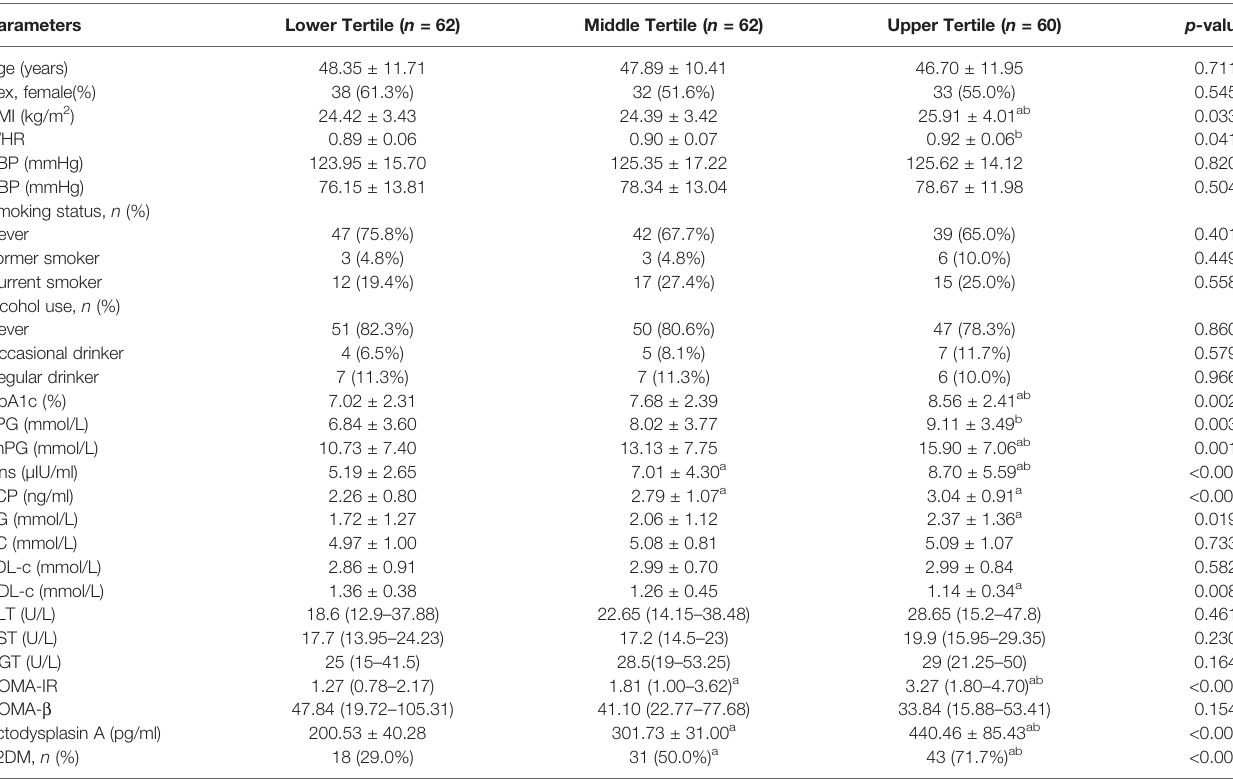
TABLE 3 | Clinical and biochemical characteristics of the study subjects according to the tertiles of Ectodysplasin A. Parameters Lower Tertile ( n = 62) Middle Tertile ( n = 62) Upper Tertile ( n = 60) p- value Age (years)